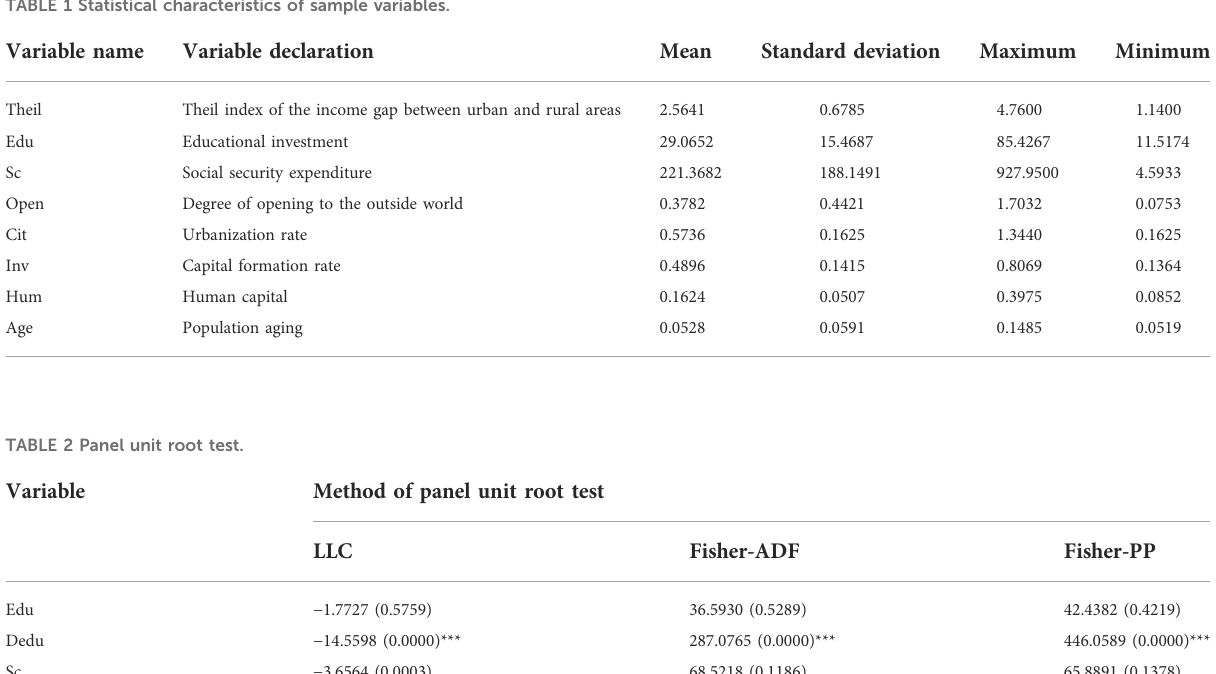
TABLE 1 Statistical characteristics of sample variables.